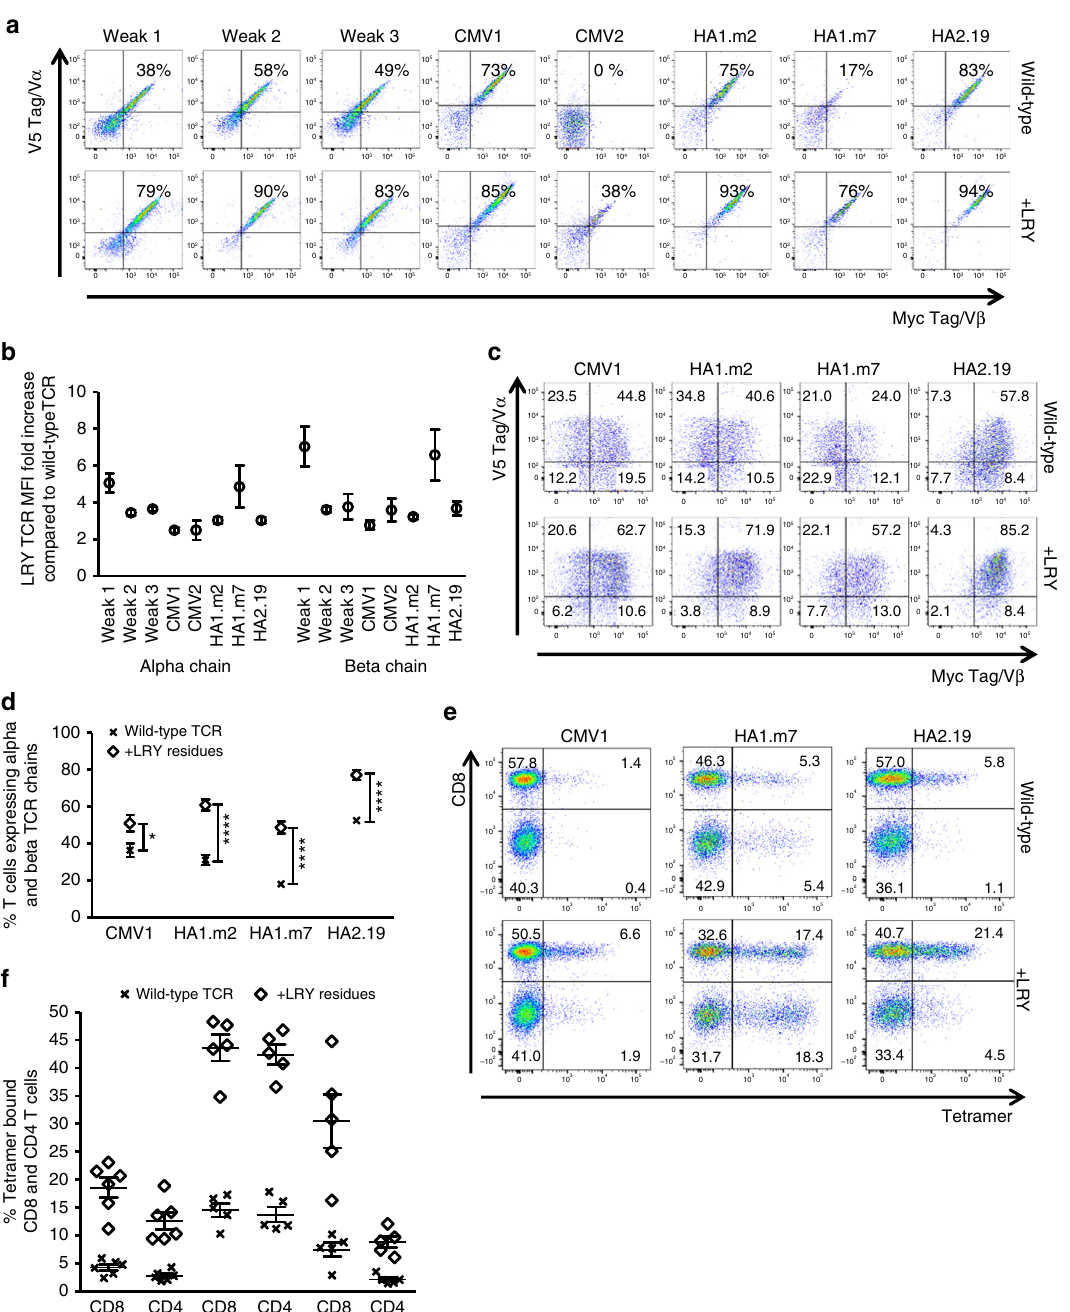
Fig. 6 Replacement of three framework residues reduces TCR mispairing and enhances TCR expression. The roles of L96 α , R9 β and Y10 β (LRY) were tested in three weak TCRs selected from the weak TCR library and in fi ve antigen-speci fi c TCRs (2 TCRs speci fi c for CMVpp65, 2 TCRs speci fi c for HA1 40 , and 1 TCR speci fi c for HA2). a A representative example of n = 3 independent experiments showing Jurkat cells (expressing an endogenous TCR) transduced with the indicated wild-type TCRs (top row) or the corresponding LRY-modi fi ed TCRs containing L96 α , R9 β and Y10 β (bottom row).TCR α / β surface expression was determined on gated cells expressing equivalent levels of CD19. b Pooled data (means ± SEM) showing the fold increase in TCR α and β chain expression for eight LRY-modi fi ed TCRs compared with the corresponding wild-type TCRs. n = 3 independent experiments. MFI median fl uorescence intensity. c Human peripheral blood T cells were transduced with the indicated wild-type or LRY-modi fi ed TCRs. The dot plots show expression of the introduced TCR α and β chains on T cells gated for equivalent expression of CD19. Data are representative of n = 5 independent experiments. d Pooled data (means ± SEM) showing the percentage of T cells expressing both TCR α and β chains when transduced with the indicated wild-type or LRY-modi fi ed TCRs. n = 5 independent experiments. P values were less than 0.05 for all comparisons between the modi fi ed TCRs and the corresponding wild-type TCRs (unpaired t -test; * P < 0.05; **** P < 0.0001). e Shown is the percentage of tetramer-binding human T cells transduced with the indicated wild-type or LRY-modi fi ed TCRs. The data is representative of at least fi ve independent experiments. f The percentages of tetramer-binding CD8 + and CD4 + T cells from n = 6 independent experiments with the CMV1 TCR, n = 5 independent experiments with the HA1.m7 TCR, and n = 5 independent experiments with the HA2.19 TCR. Data are shown as mean ± SEM. V α variable alpha, V β variable beta NATURE COMMUNICATIONS| (2019) 10:4451